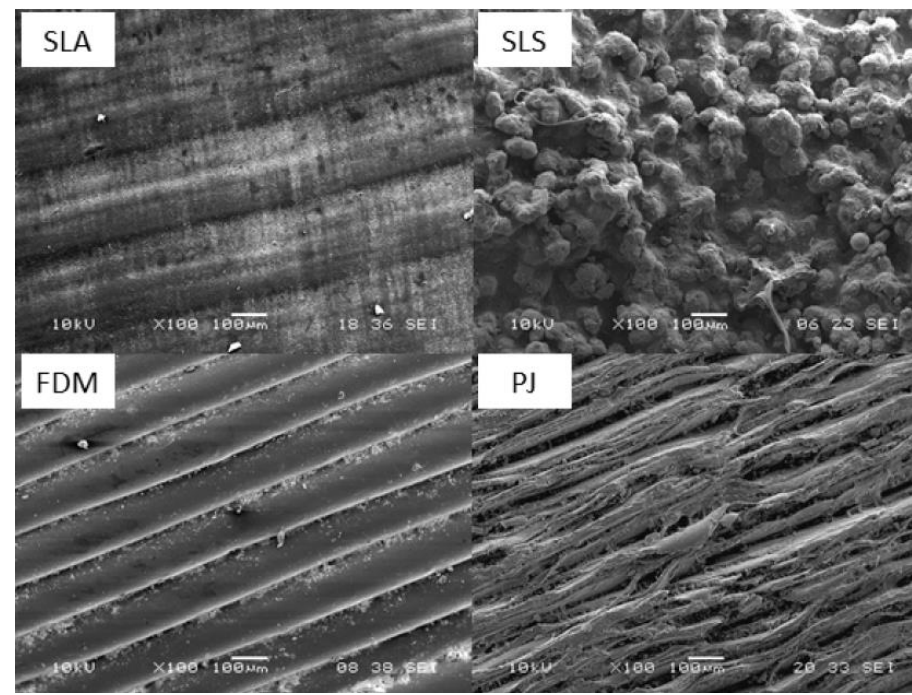
Figure 3. Printed surfaces for SLA, SLS, FDM and MJ samples [96].